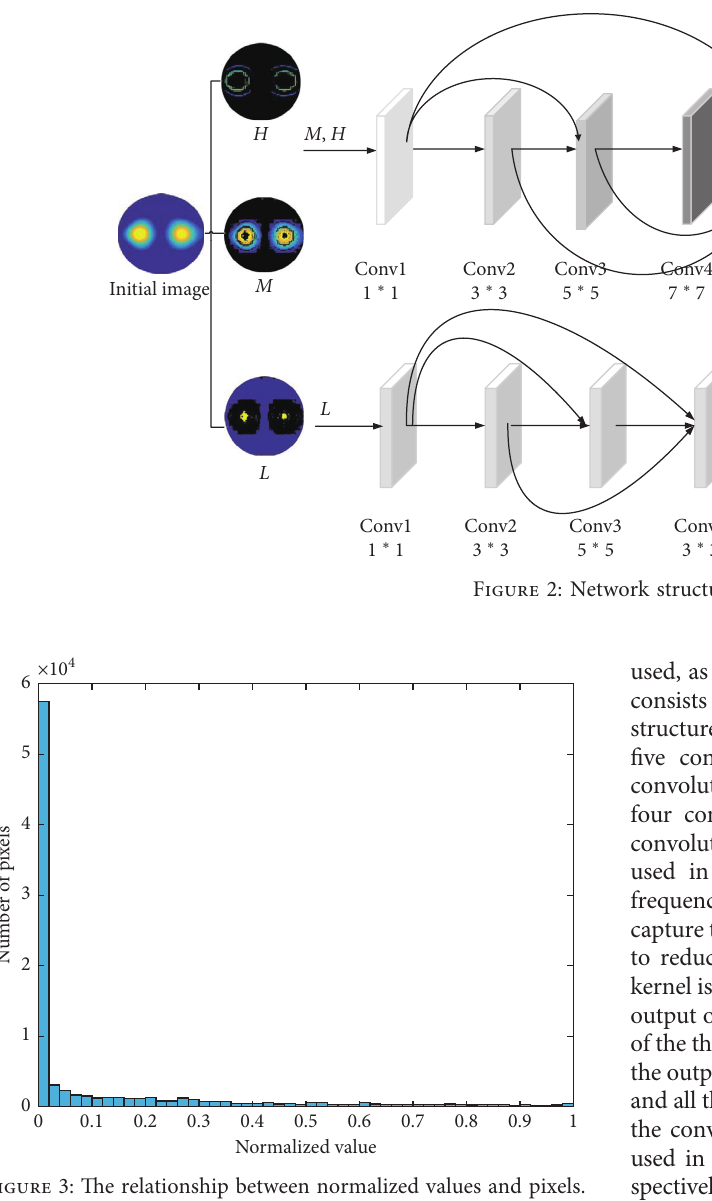
Figure 3: The relationship between normalized values and